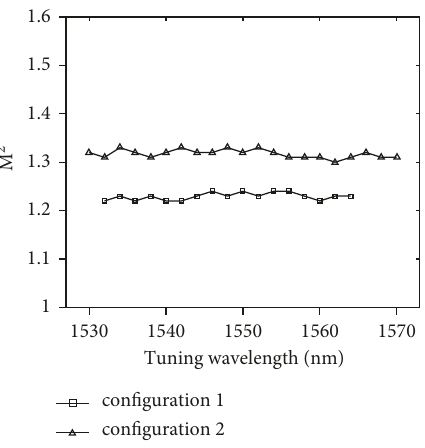
Figure 12: Wavelength verse beam